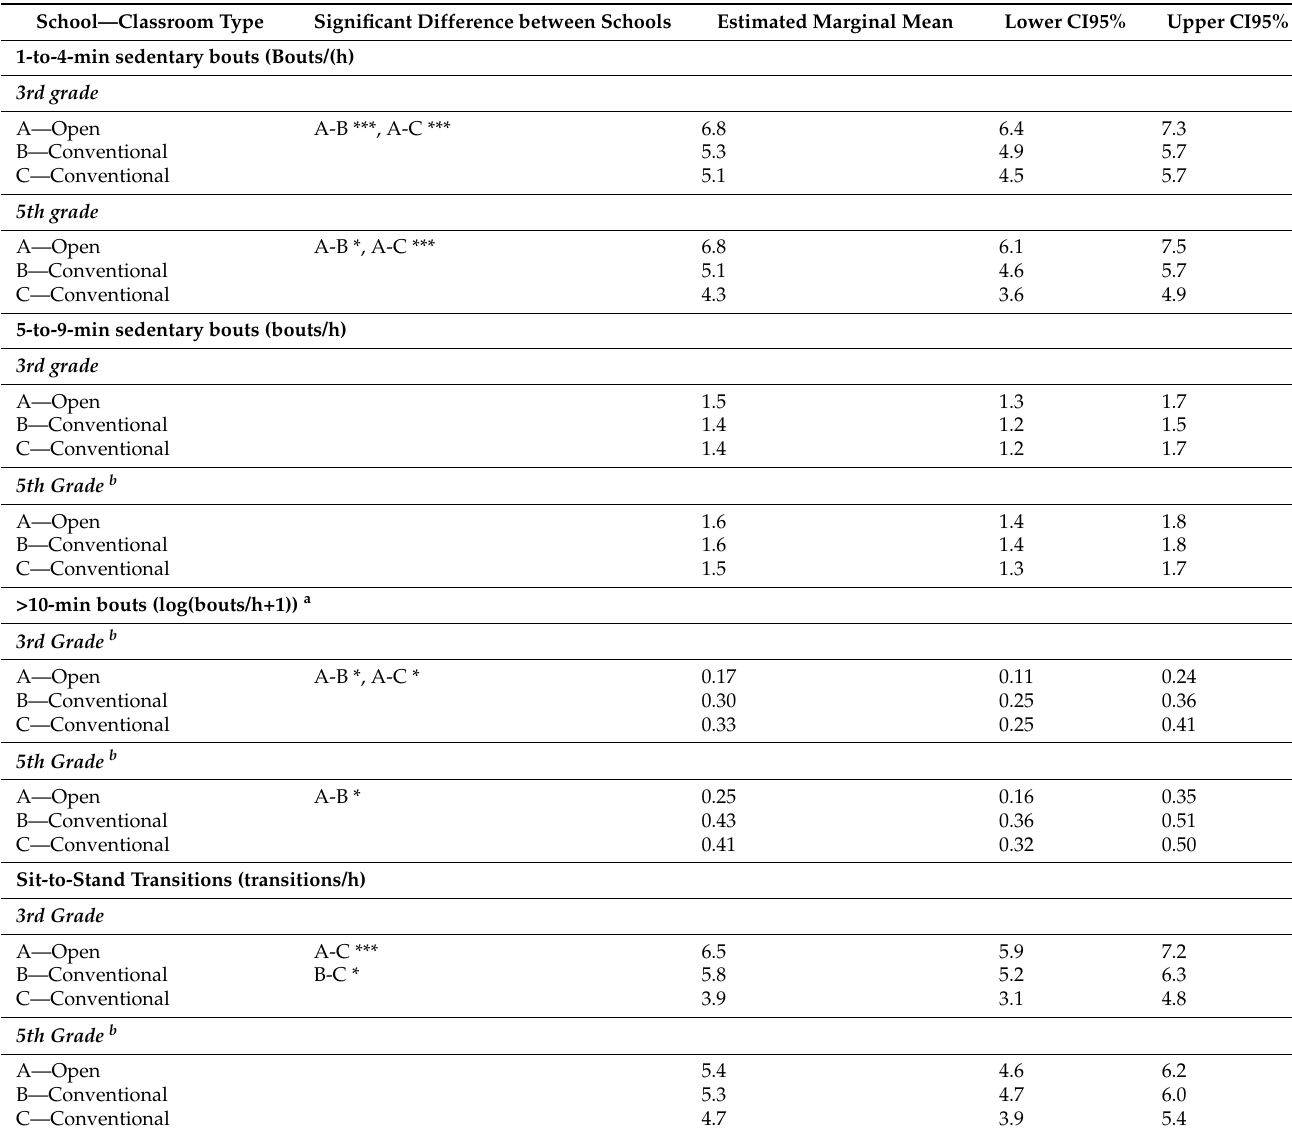
Table 4. Grade-matched between school-estimated marginal means of sedentary behavior variables controlled for